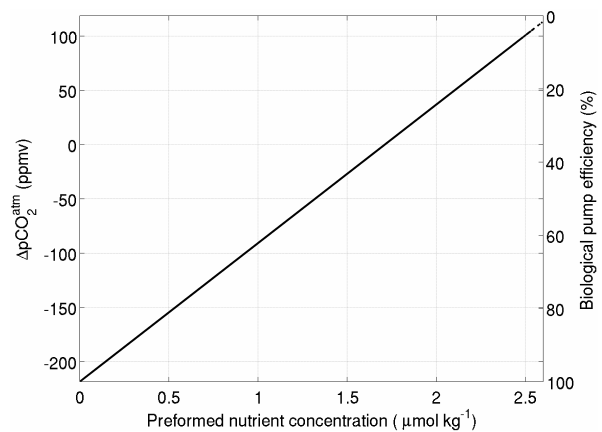
Fig. 2. Changes in the atmospheric CO 2 in the model as a func- tion of the preformed nutrients for all 10 7 solutions (left axis) as calculated according to the theory of Ito and Follows (2005). A zero 1p CO 2 is assumed at the average preformed nutrient concen- tration of our 300 best interglacial solutions (see Sect. 3.2 for an explanation of how these are derived). The 1p CO 2 and preformed nutrients are also linearly related to the efficiency of the biological pump (right